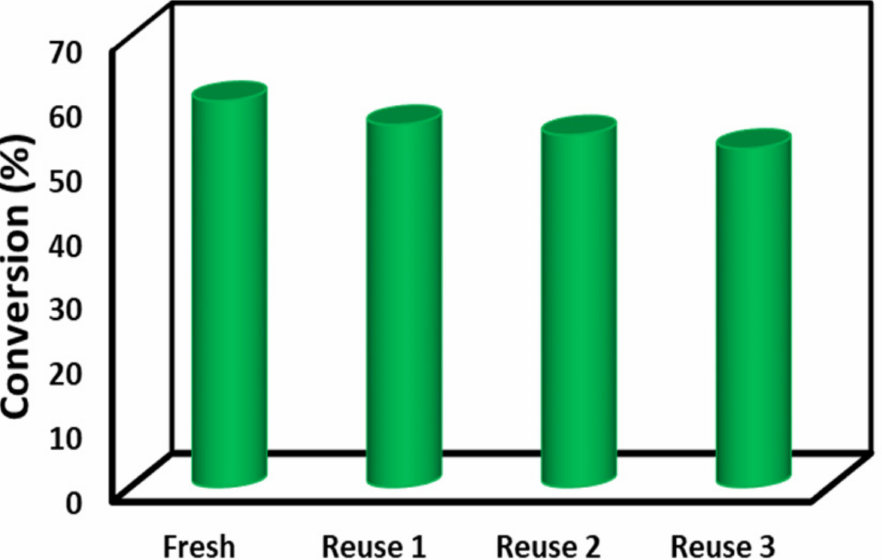
Figure 9. Reusability study of the MOF-801catalyst for the transesterification of